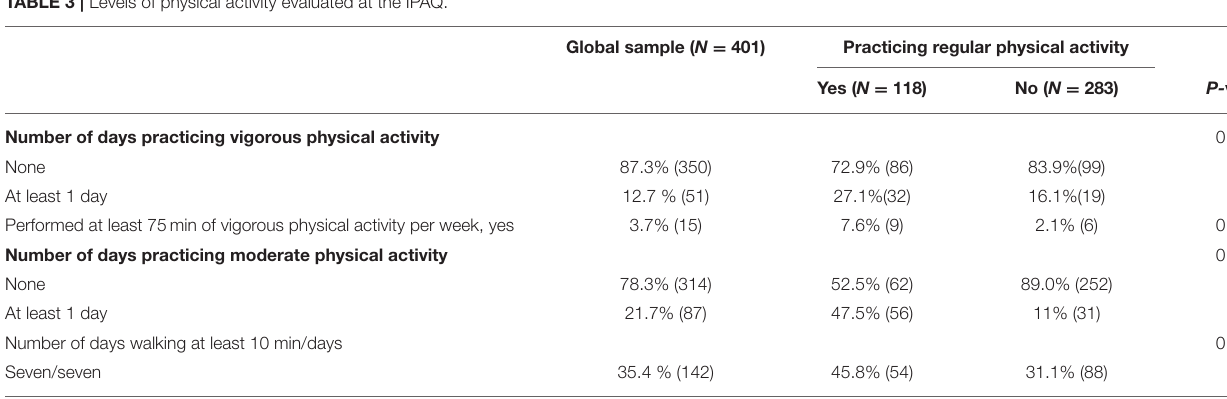
TABLE 3 | Levels of physical activity evaluated at the